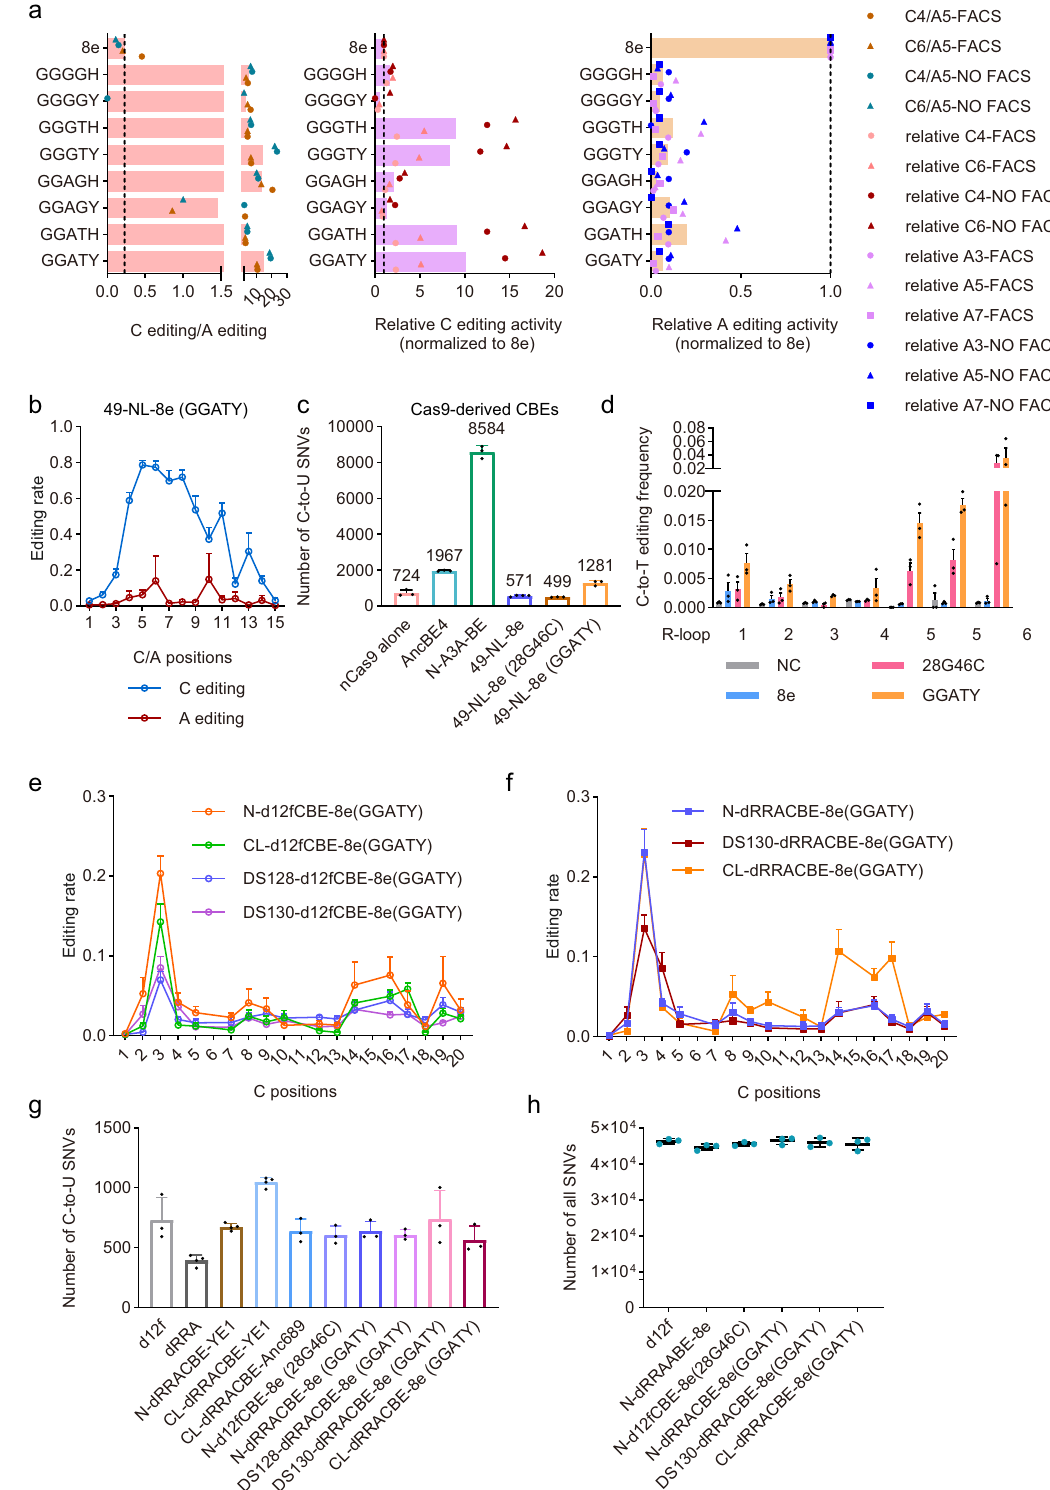
(Supplementary Fig. 22-23). For all 4 off-target sites of 12f-sgEMX, no detectable off-target DNA edits were induced (Supplementary Fig. 24).